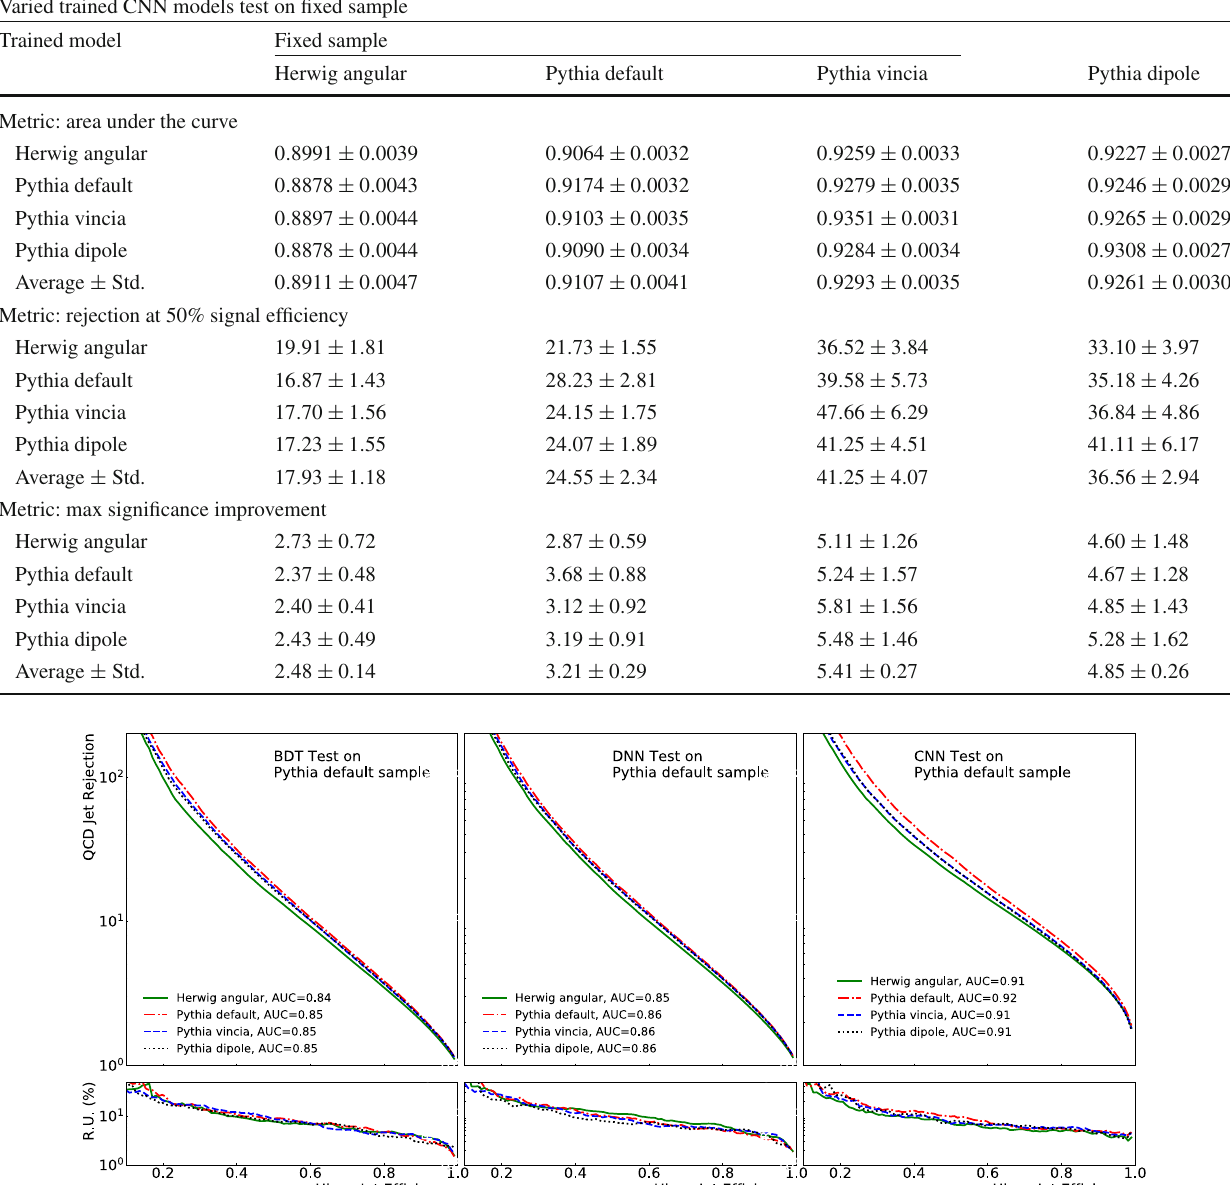
Table 7 Area under the curve, rejection at 50% signal efficiency and maximum significance improvement for the CNN model. The last rows are the average and standard deviation over the mean values from the other rows Varied trained CNN models test on fixed sample Trained model